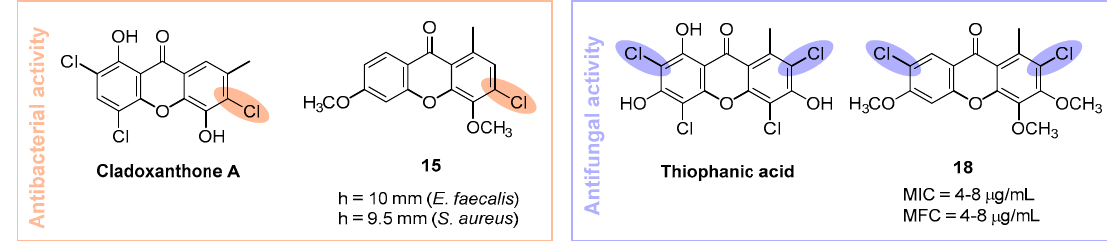
Figure 3. Structure-activity relationship.